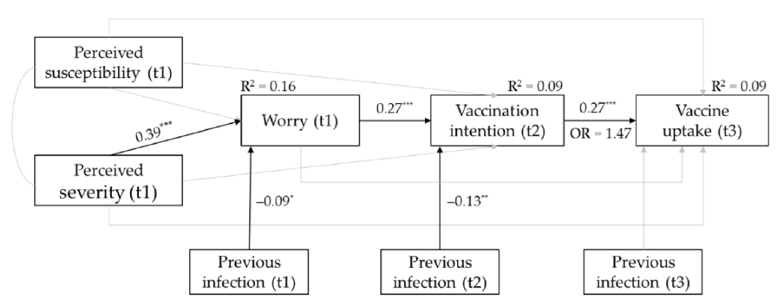
Figure 2. Results of the tested sequential mediation model. Grey paths were not statistically signif- icant. * p < 0.05, ** p < 0.01, *** p <